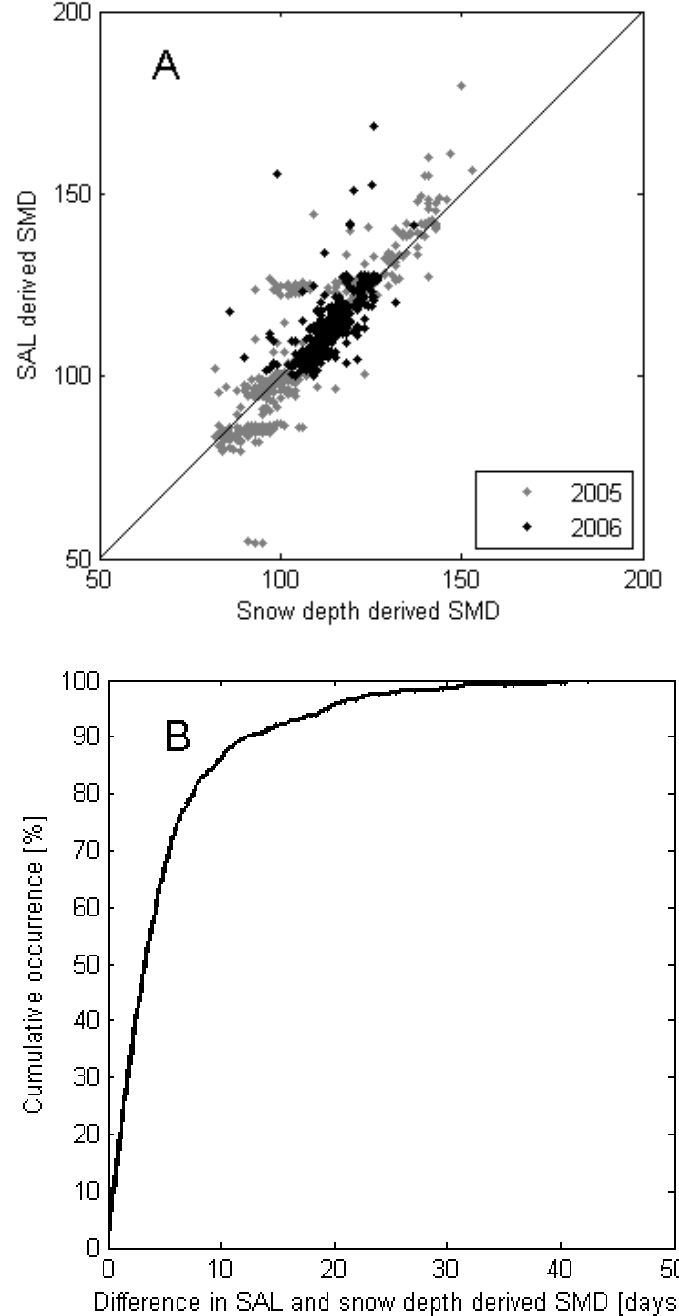
Figure 3. ( A) Snow melt day (SMD) as derived using the SAL surface albedo product plotted against that derived from surface snow depth measurements. The grey dots are observations from the year 2005 and the black ones from the year 2006. The solid line indicates the 1:1 relation; (B) Cumulative distribution of the absolute differences between SAL and snow-depth-derived